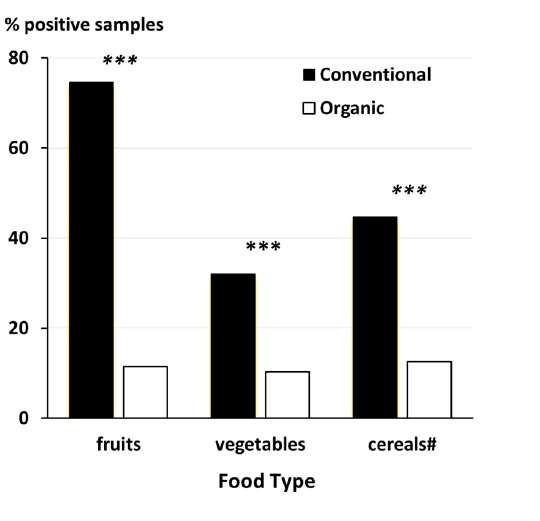
( c ) Figure 8. Effect of organic and conventional production methods on the total pesticide residue concentrations in ( a ) whole- grain and white/refined wheat flour, ( b ) spelt and common wheat flour and ( c ) wheat flour samples produced in the UK and Germany). Data from [140]. Means/bars for the same production system (=same color) labelled with the same lower- case letter and means/bars for the same flour types, wheat species or country labeled with the same capital letters are not significant different ( p < 0.05). These results are consistent with regulatory pesticide monitory data from Europe, which also suggest that pesticide residue levels in whole-grain cereal products, fruit and vegetables are higher than in food such as refined cereal products, and most meat and dairy products [128]. It is important to note that the concentrations of pesticides in pesticide-treated crops may also be affected by both environmental conditions and agronomic practices other than pesticide use [58,142–144]. For example, wheat produced with conventional, pesti- cide-based crop protection regimes had significantly higher chlormequat levels in ma- nure-fertilized plots, compared with mineral NPK-fertilized plots in the NFSC trial [58] (Figure 9). Chlormequat is a plant-growth regulator that is licensed in the EU only for use in cereals (especially wheat) to prevent lodging. The higher chlormequat residues in ma- nure-fertilized crops are thought to be due to the 1–2-week earlier wheat grain maturity Ba Ba Ba Ba Ba Ba